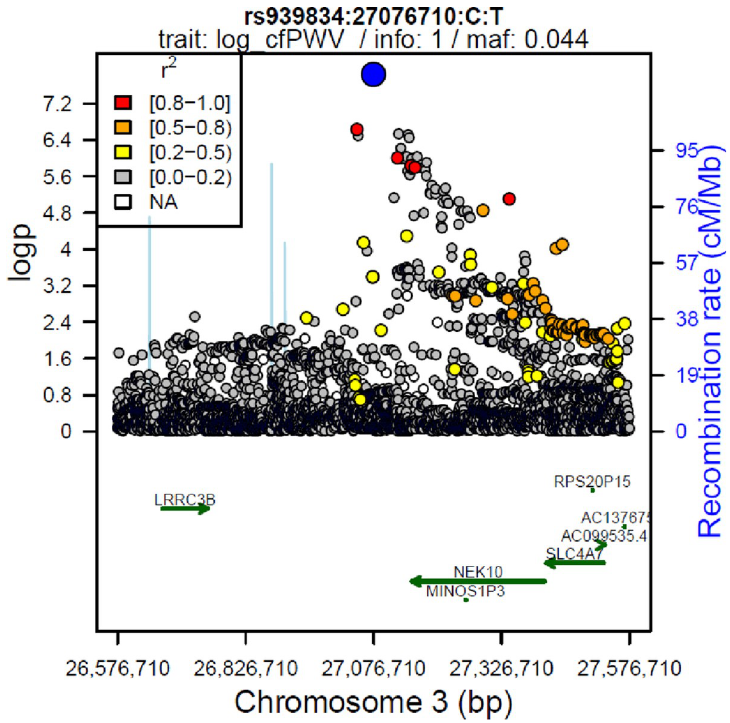
Fig 3. Regional association plot for top SNP rs939834 with cfPWV. The top SNP is coloured blue, the other SNPs according to their LD with the lead SNP). P-values are shown for cfPWV only. The top SNP is strongly supported by additional variants. SLC4A7 as cis-eQTL gene in the same locus is known to effect vascular smooth muscle cells